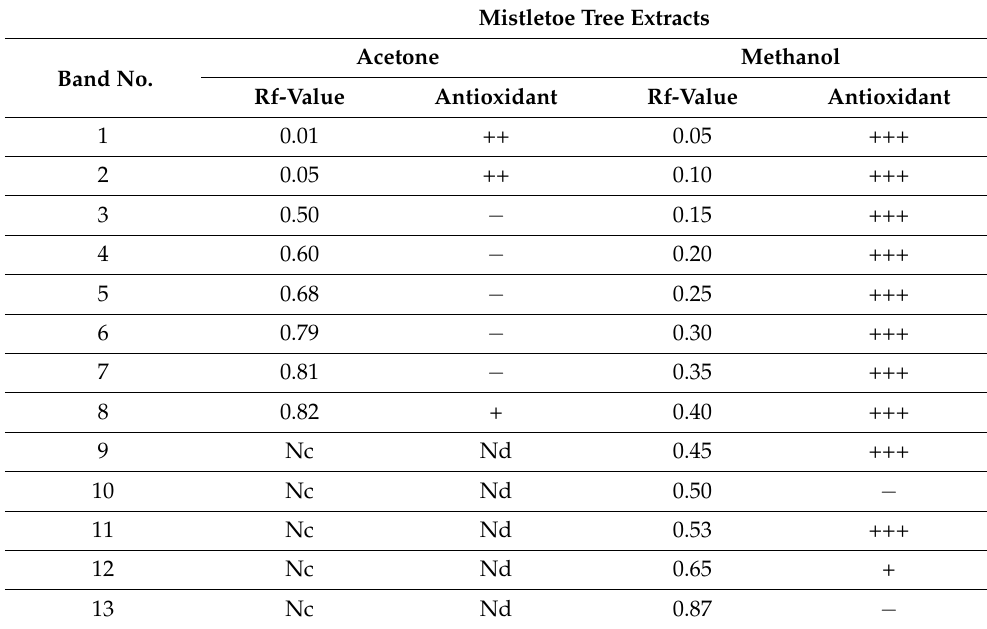
Table 3. Phytochemical bands present in the polar acetone and methanol extracts of Mistletoe tree.